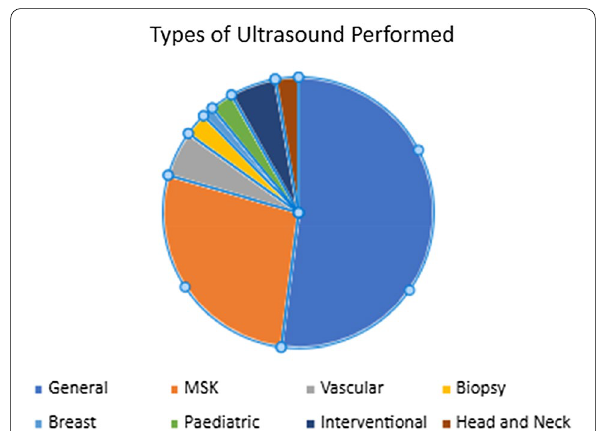
Fig. 2 Types of ultrasound performed. MSK